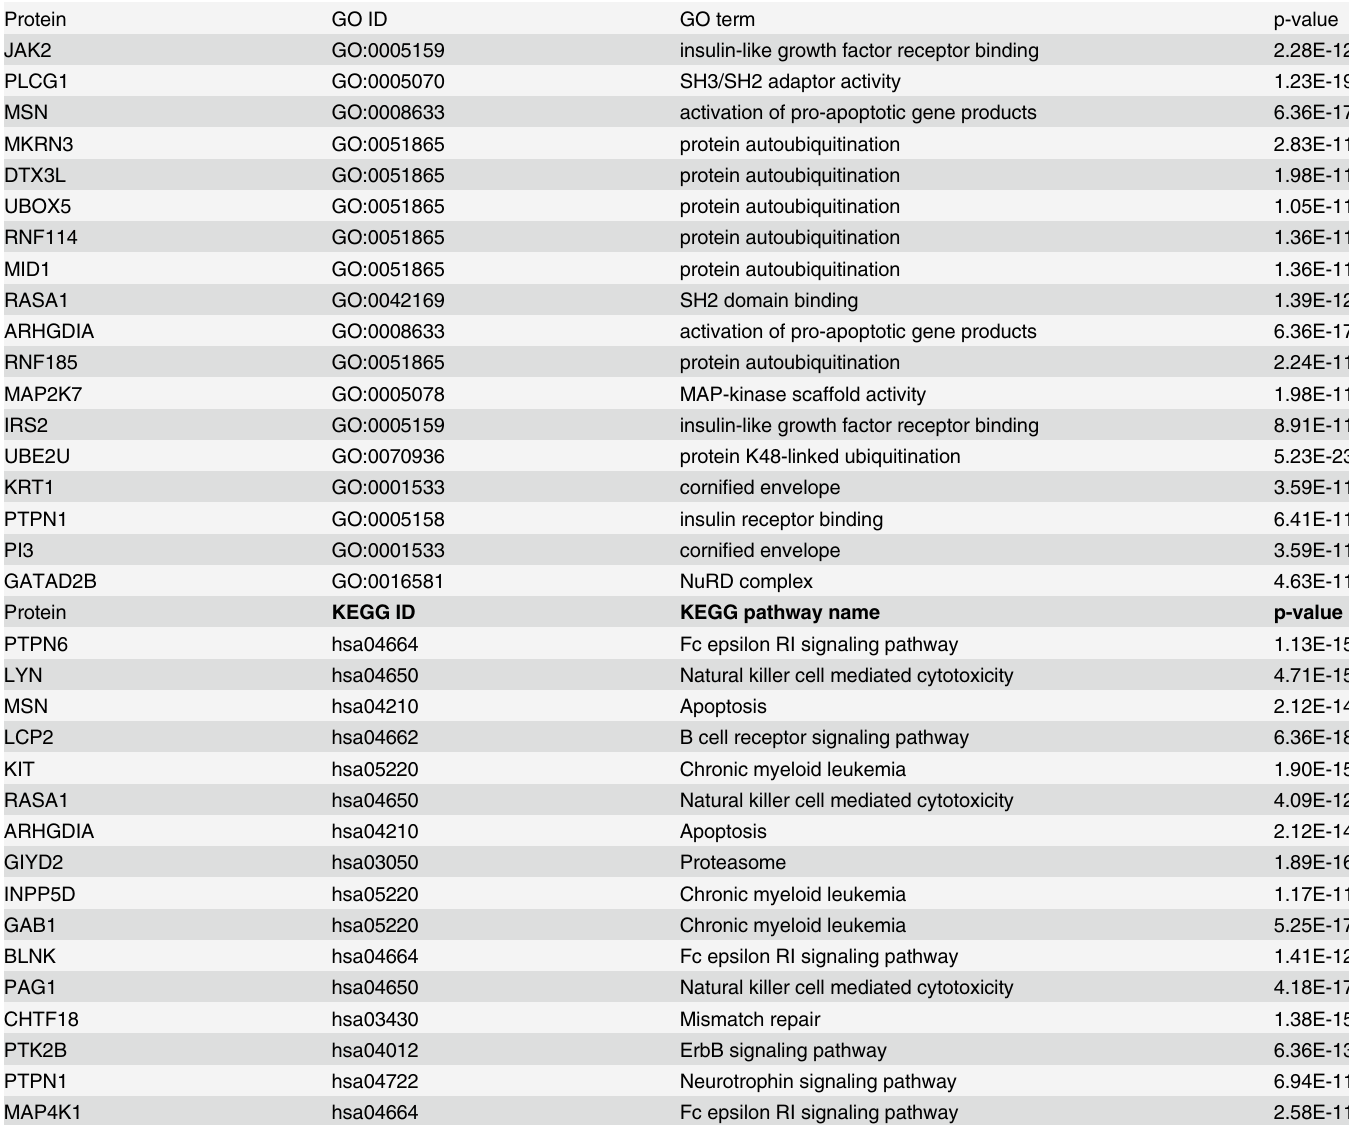
Table 1. Predicted GO and KEGG annotations that are worth further